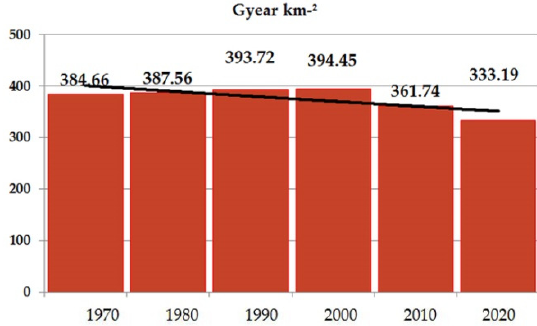
Figure 15. Specific real soil losses per km 2 (m 3 km − 2 yr − 1 ).